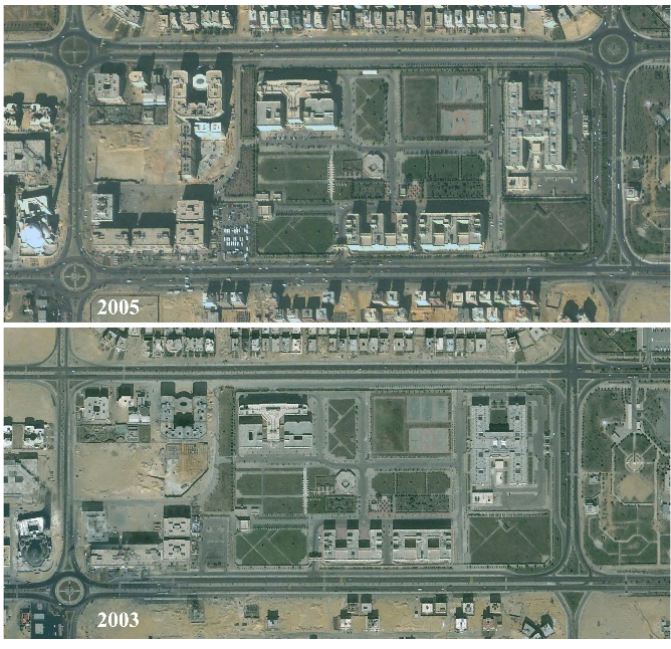
Figure 3. O6U intimate